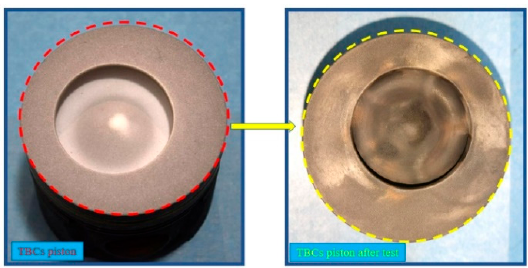
Figure 3. YSZ coated piston before and after test.